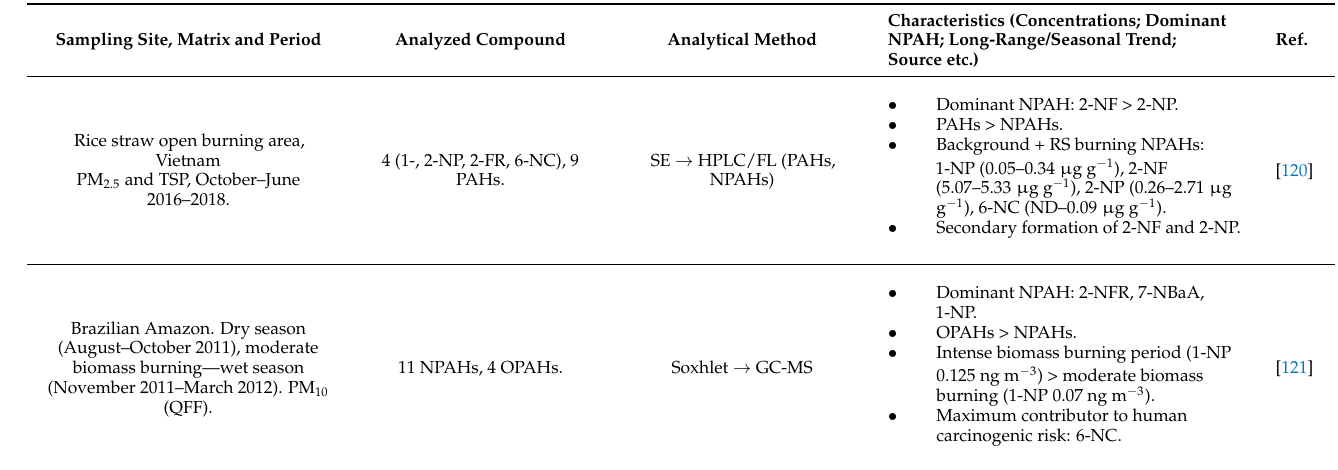
Sampling Site, Matrix and Period Analyzed Compound Analytical Method